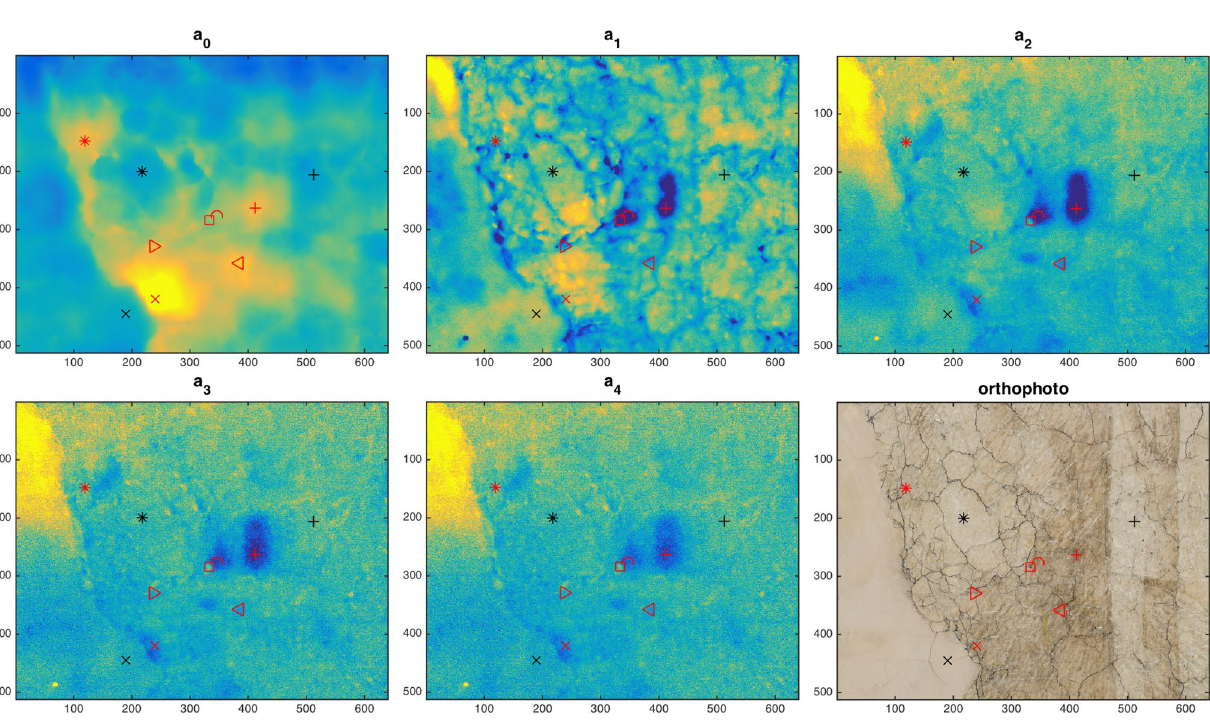
Figure 5. Maps of the polynomial coefficients decomposition with the referencing orthophoto for a selected frame of the mosaic, same 500 µ m pixel size at object plane. Red markers indicate the detached regions validated by the restorer, in particular (+) was identified as very serious defect. Among the sound regions marked in black, ( ) is located in a part of the wall outside the painting that is well discriminated by TQR (see Fig. ×